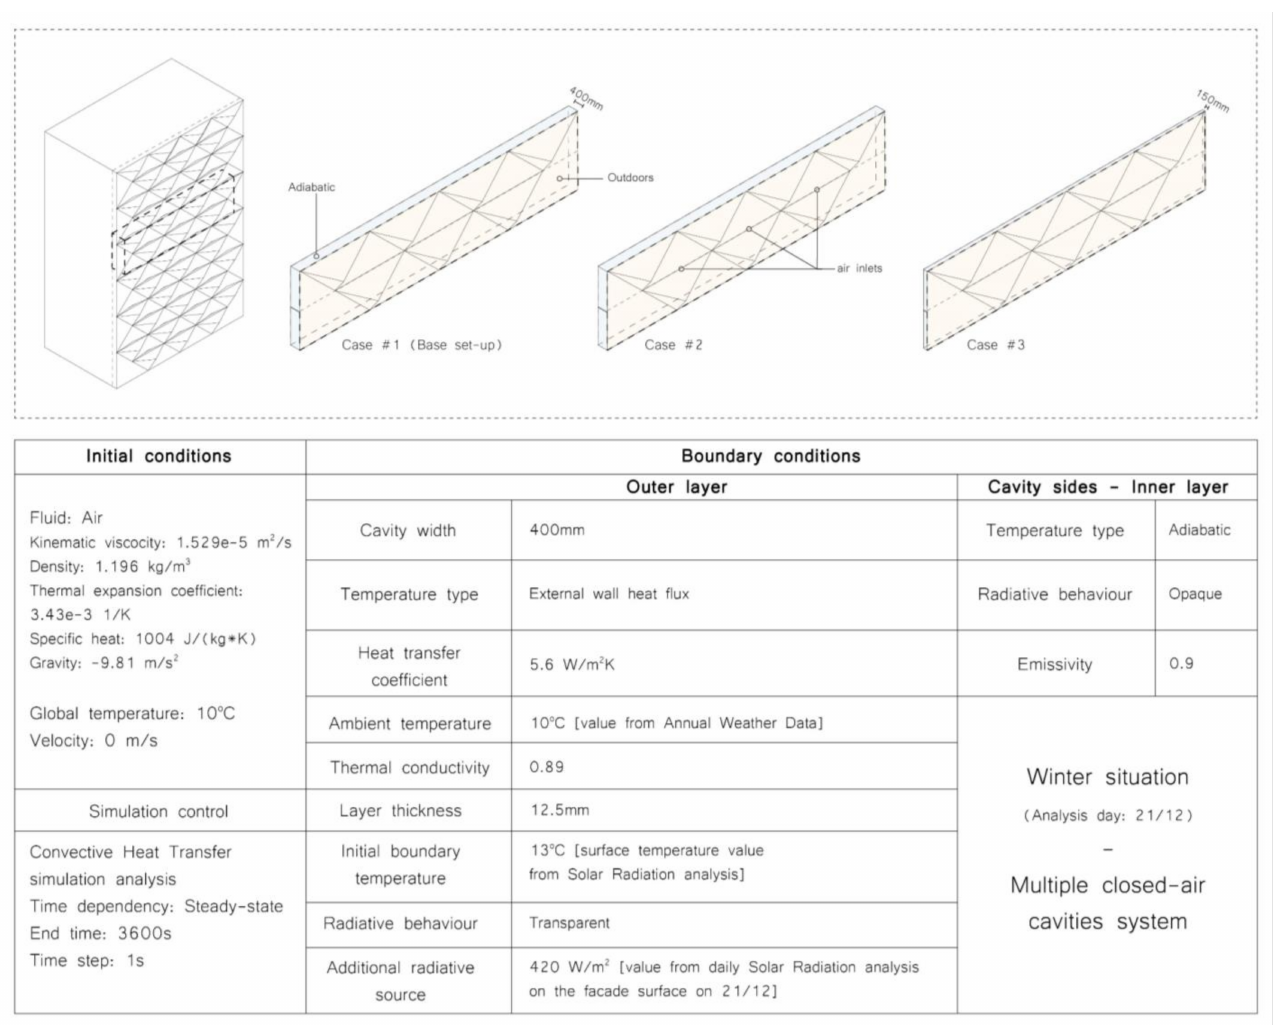
Figure 15. Overview of the input parameters and boundary conditions for the SimScale CFD convec- tive heat transfer analysis in the winter